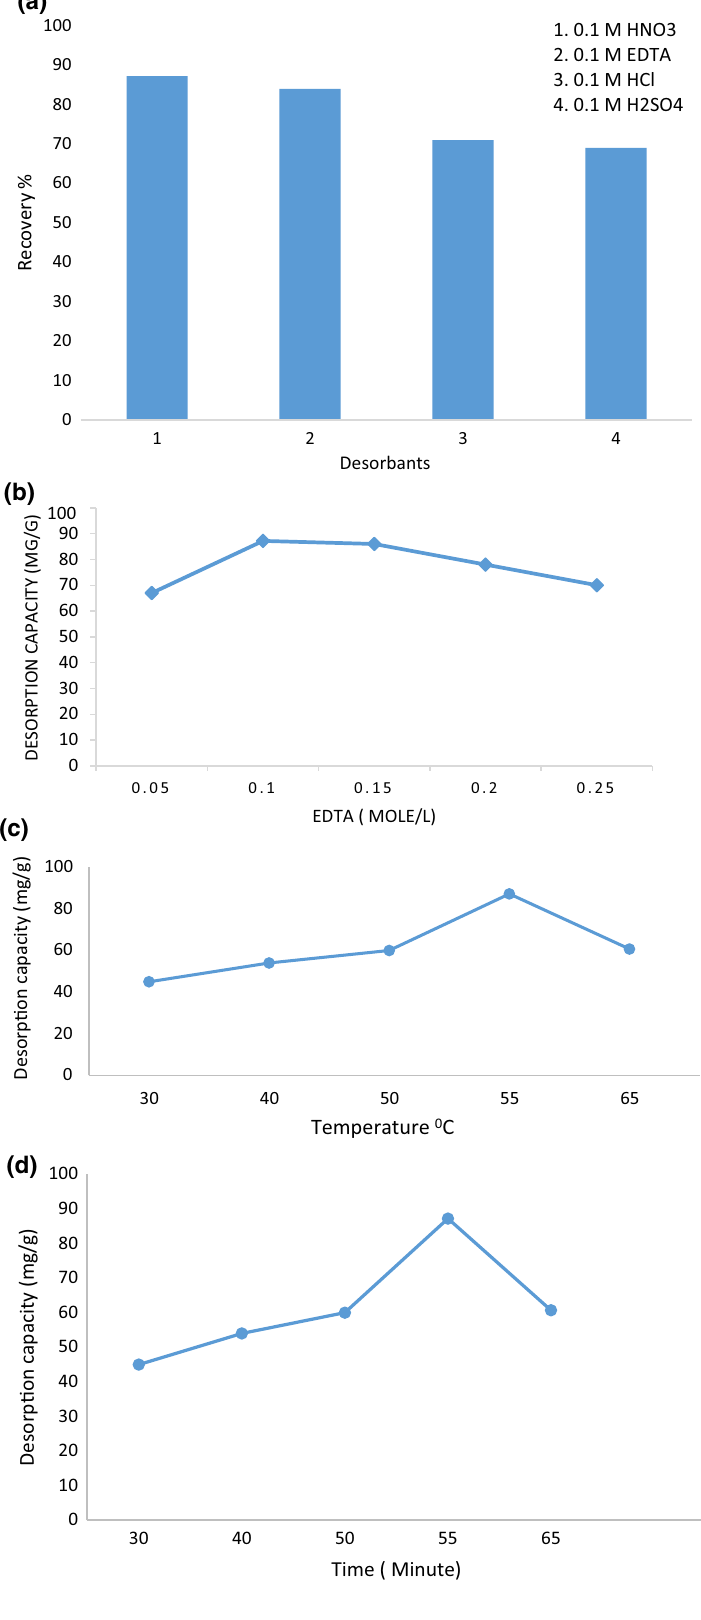
Fig. 8 a Cd (II) recovery by different desorbents. b Effect of EDTA concentration on desorp- tion capacity of algal biomass (sample dose 0.1 g, temperature 55 °C; time 45 min). c Effect of temperature on desorption capacity of algal biomass. (sam- ple dose 0.1 g, EDTA concen- tration 0.1 mol/L; time 45 min.) d Effect of time on desorption capacity of algal biomass. (sam- ple dose 0.1 g, EDTA concen- tration, 0.1